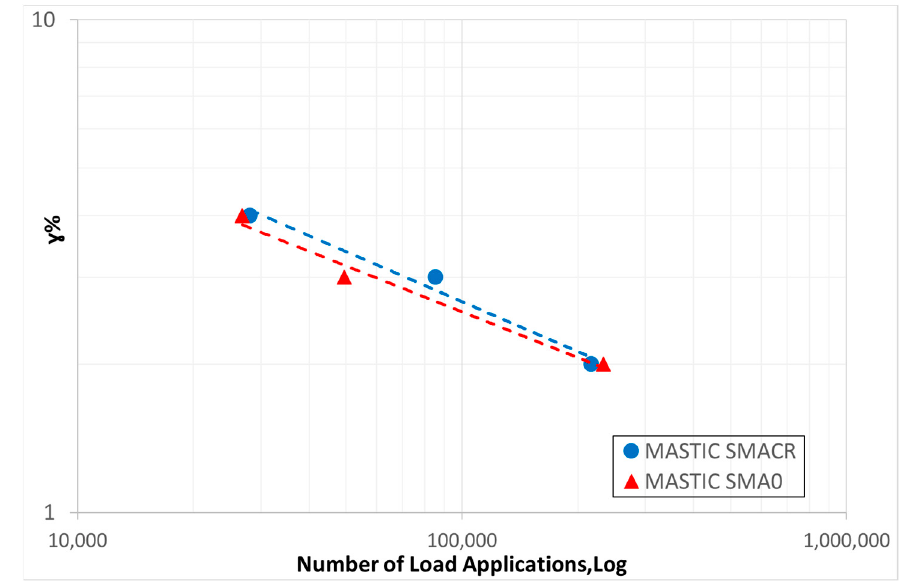
Figure 13. Mastics time sweep test comparison.